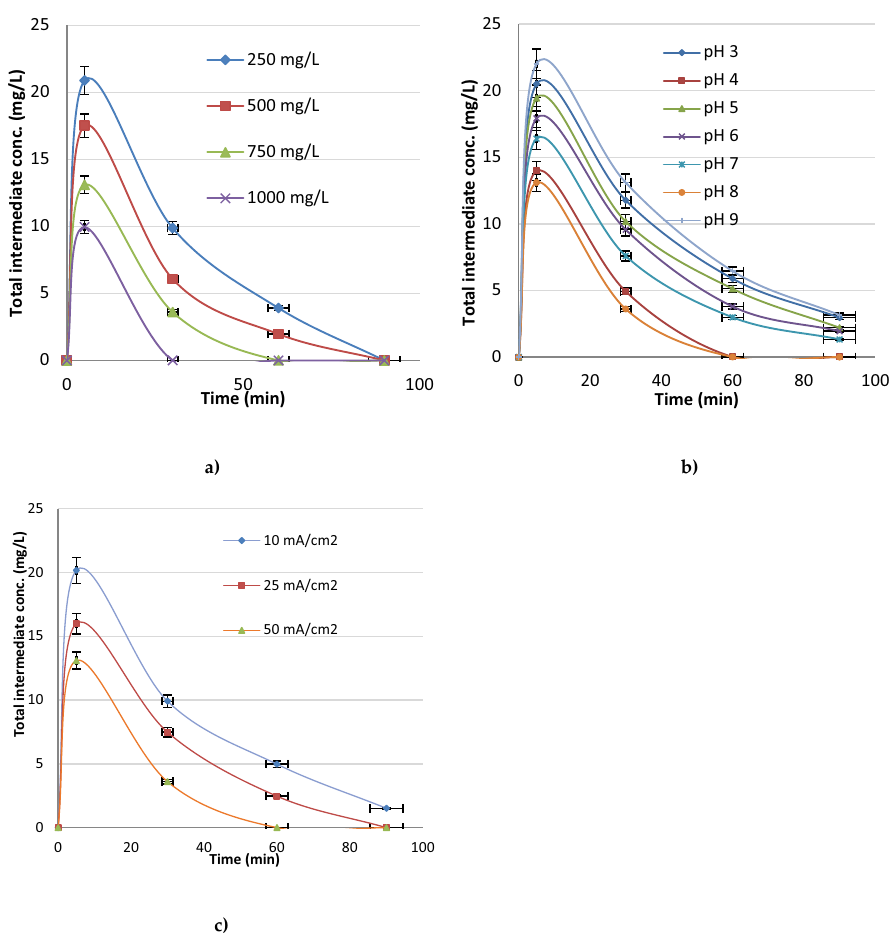
Figure 7. Total intermediate product formation ( a ) effect of KCl concentration (pH 8 and I: 50 mA cm − 2 ) ( b ) effect of pH (KCl conc.: 750 mg/L, I: 50 mA/cm 2 ) ( c ) effect of current density (KCl conc.: 750 mg/L, pH